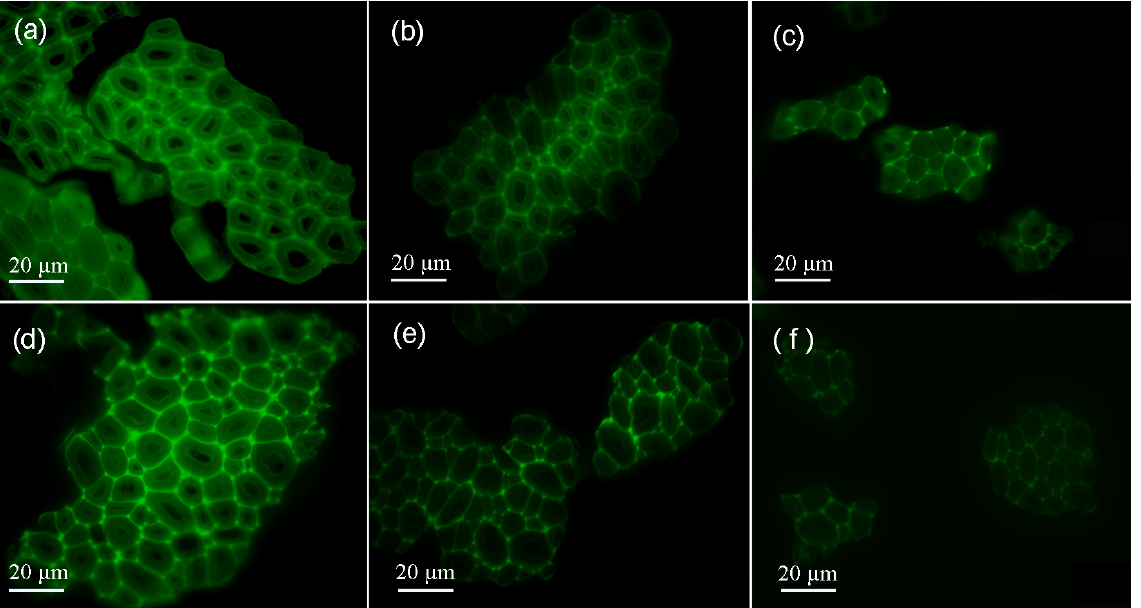
Figure 6. Cross section of the cotton stalk fibers treated in the alkali/glycerin mixtures ( a ) at the initial stage, ( b ) in the middle stage and ( c ) at the end of the treatment compared with that of the fibers treated in the alkaline aqueous solution ( d ) at the initial stage, ( e ) in the middle stage and ( f ) at the end of the treatment.